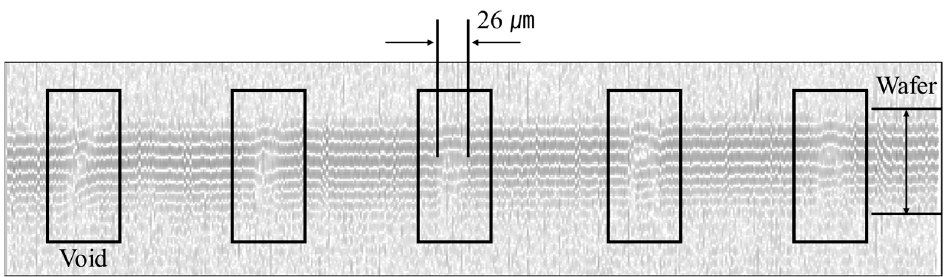
Figure 11. The –63 μ m defocusing B-Scan image of TSV. Figure 11. The –63 µ m defocusing B-Scan image of